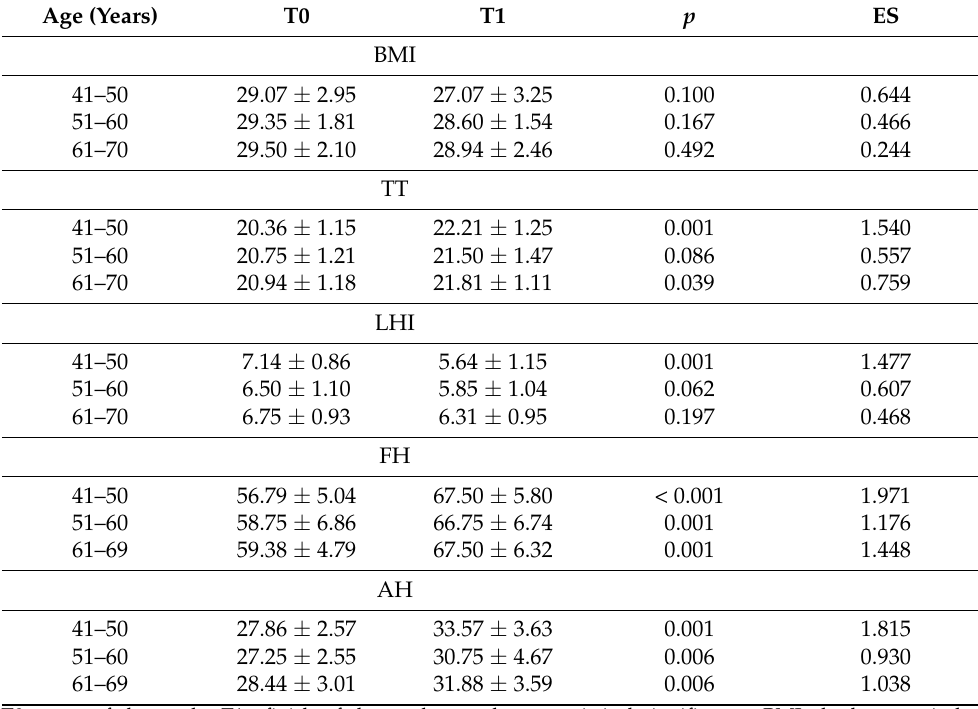
Table 5. The evolution of modifiable parameters the group A during the study by age